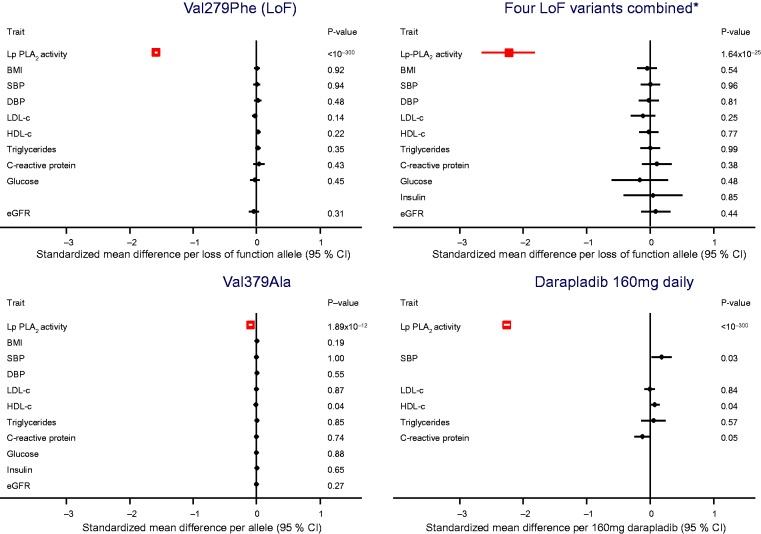
Mean per allele differences in Lp-PLA2 activity and cardiovascular risk factor levels by Lp-PLA2-lowering alleles or with darapladib 160 mg daily. To enable comparison of the magnitude of associations across several different markers, analyses were undertaken with standardized units of measurement for each marker. Associations are presented as per allele change in the biomarker expressed as standard deviations. Numbers of participants are provided in Table 1. Details of contributing studies are provided in Supplementary Material Tables 2 and 3 online.*Carriage of any of the four loss-of-function variants c.109+2T>C, Arg82His, Val279Phe, Gln287Ter.BMI: body-mass index; CI: confidence interval; DBP: diastolic blood pressure; eGFR: estimated glomerular filtration rate; HDL-c: high-density lipoprotein cholesterol; LDL: low-density lipoprotein cholesterol; LoF: loss-of-function; Lp-PLA2: lipoprotein associated phospholipase A2; SBP: systolic blood pressure